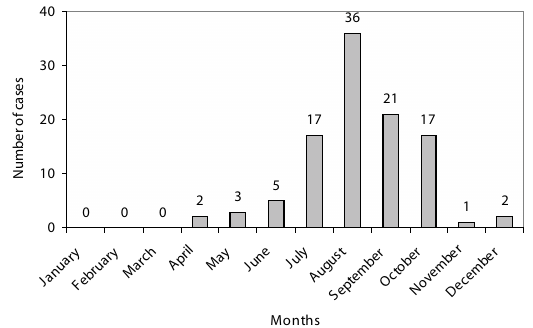
Figure 1. Incidence of enteroviral meningitis cases by